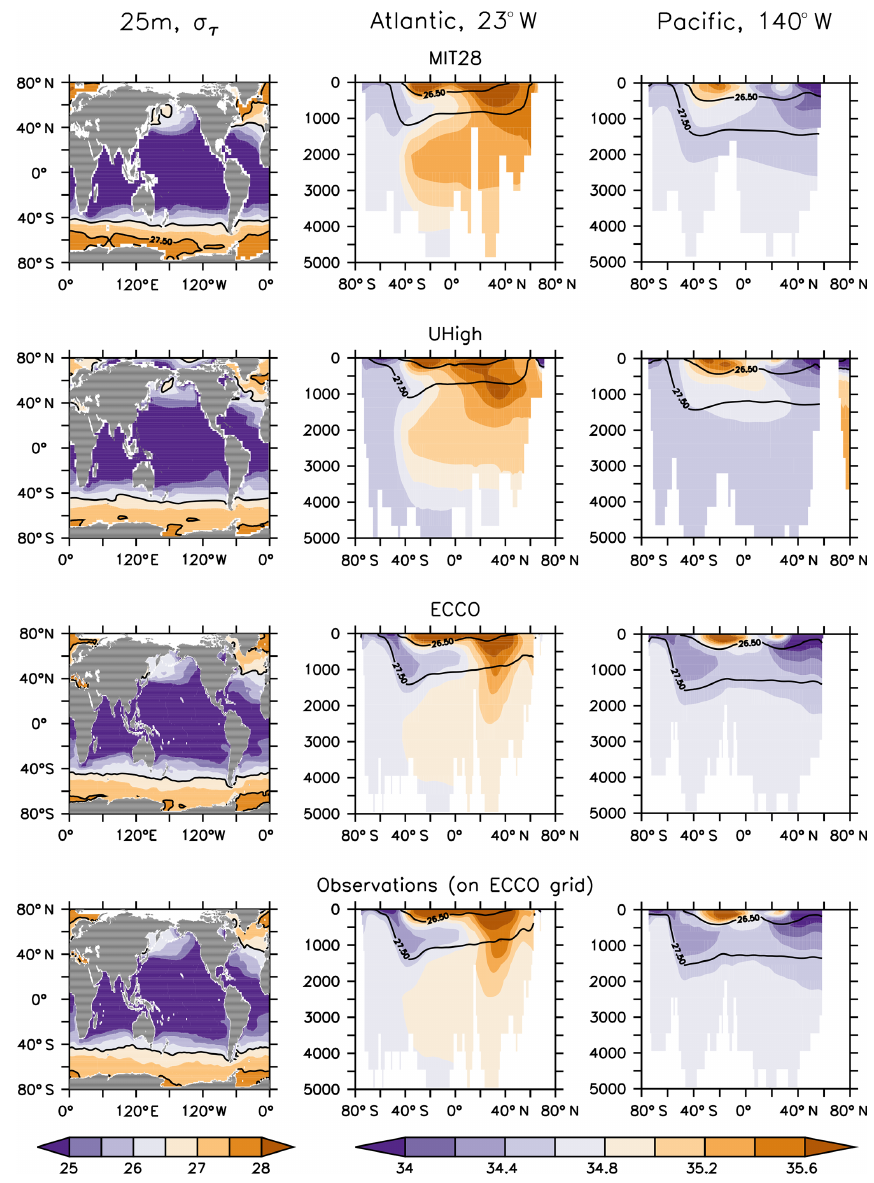
Figure 1. Density ( σ θ ) at 25m (left panels) and salinity along sections at 23 and 140 ◦ W (middle and right panels) of forcing from (top to bottom) MIT28, UHigh and ECCO circulation. The bottom row of panels show observations mapped onto ECCO geometry. Density has been derived from annual mean potential temperature and salinity. Contour lines highlight isopycnal of σ θ = 26 . 5 and σ θ = 27 .